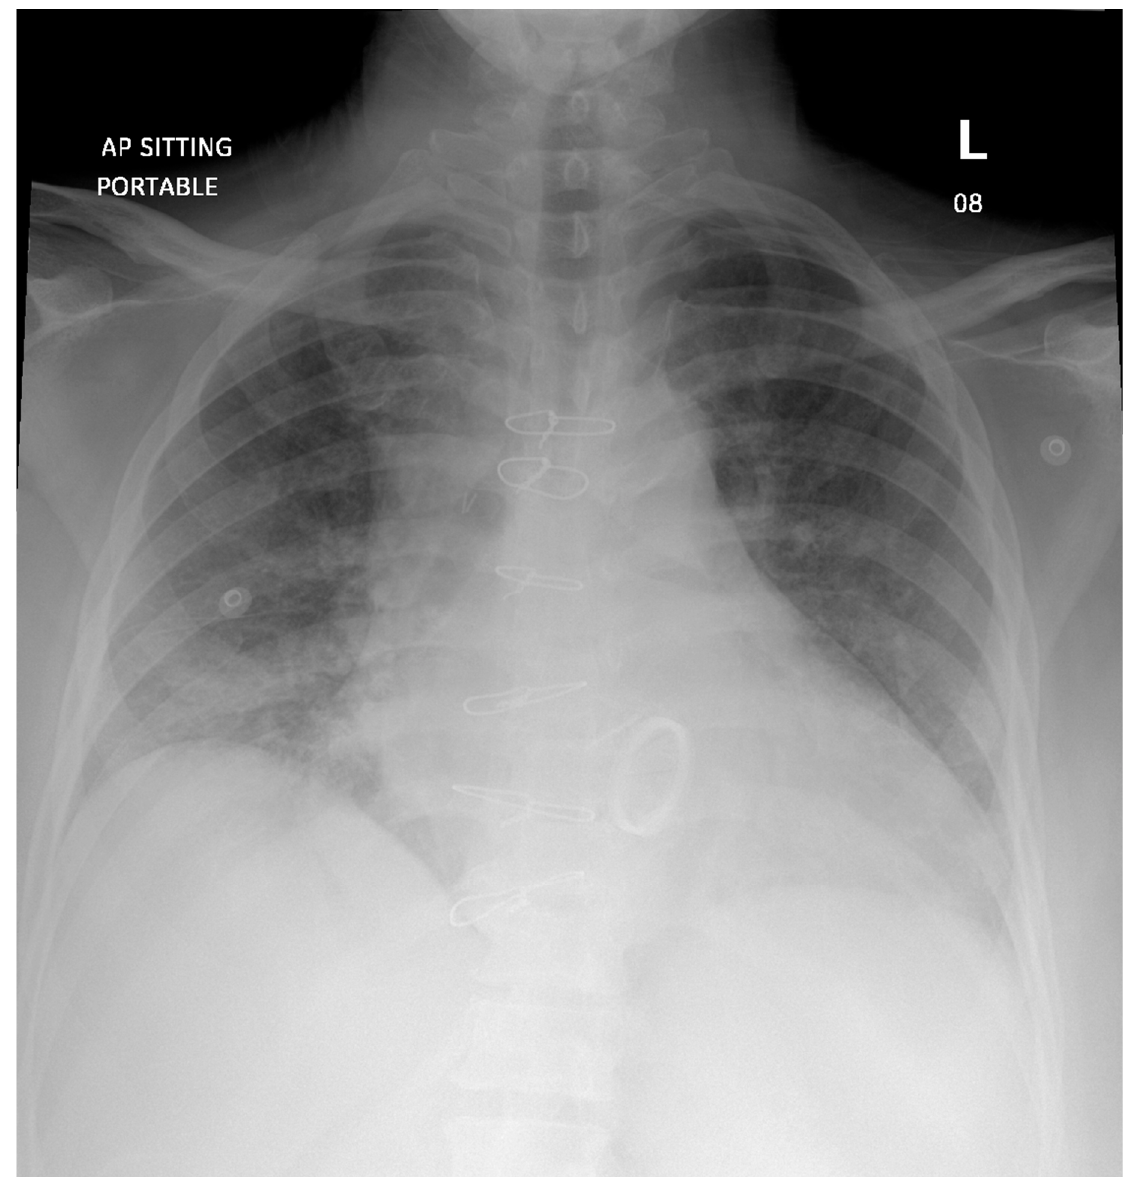
Figure 1. Chest X-ray showing bilateral airspace opacities and interstitial infiltrates representing pulmonary edema.